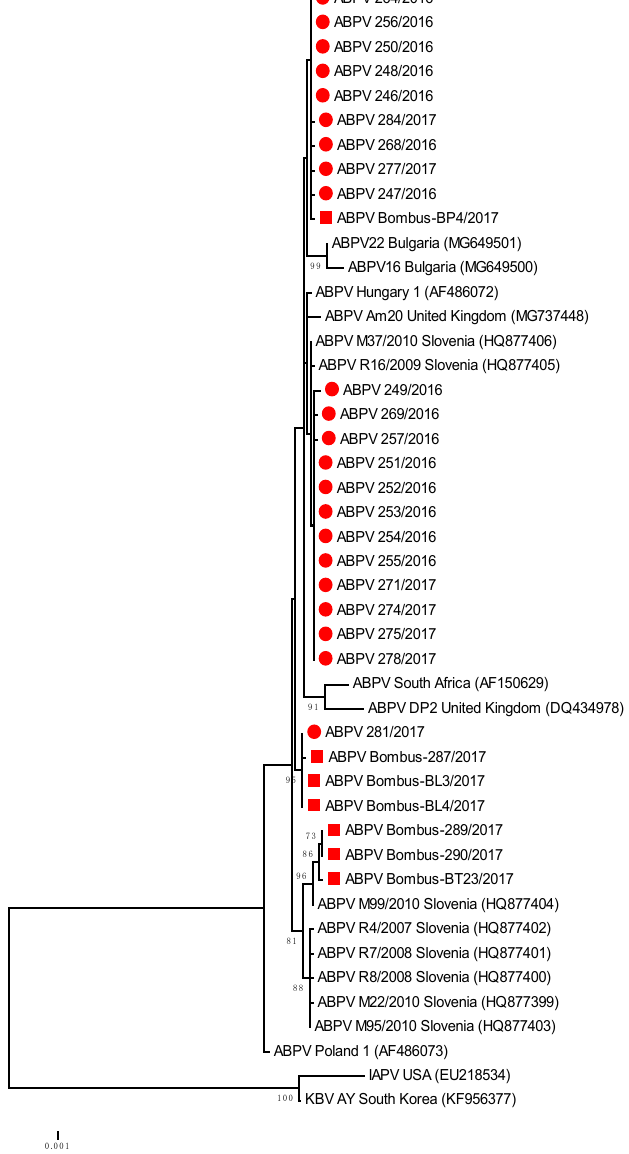
Figure 2. Phylogenetic comparison of 408 nucleotide-long sequences of ORF 1 (RNA-dependent RNA polymerase gene) of ABPV (nt genome position between 5.281 and 5.688, numbering according to strain Hungary 1, AF486072) for 25 positive samples obtained from honeybees ( ● ) and eight positive bumblebee samples ( ■ ) in this study. The maximum likelihood tree is presented for 33 Slovenian ABPV samples with 17 strains from GenBank (with accession numbers).